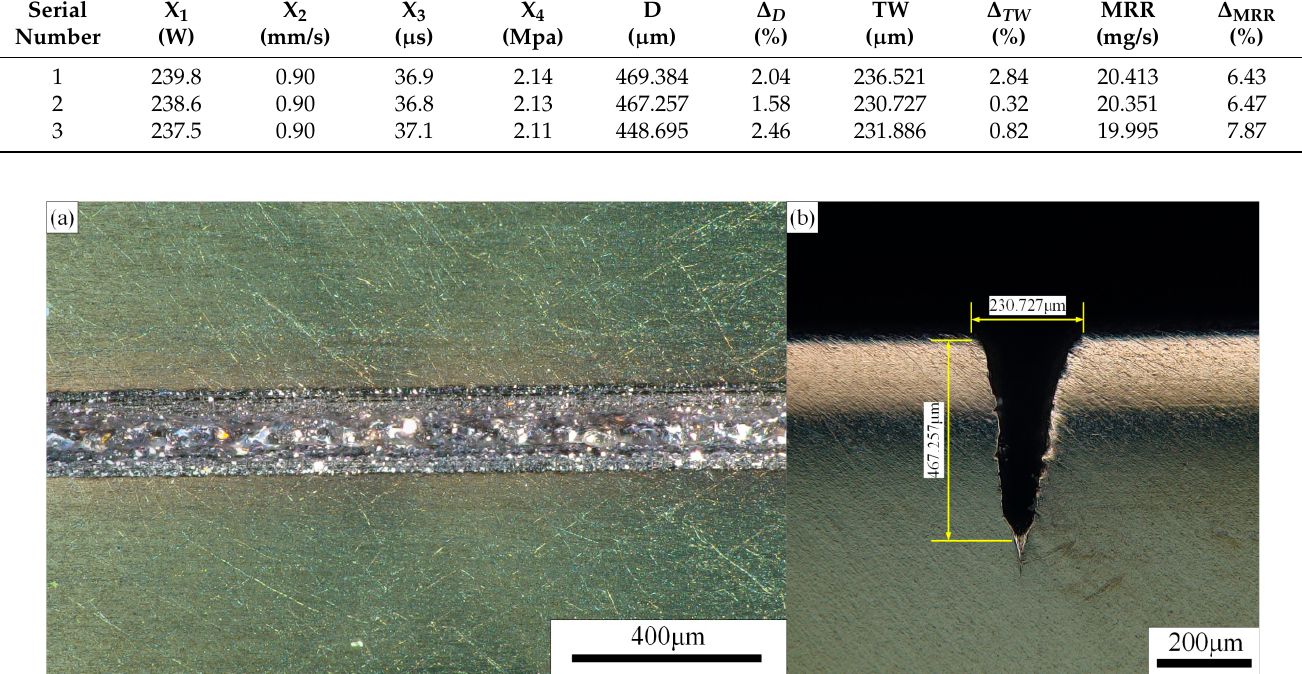
Figure 18. Microgroove morphology after optimization of process parameters. ( a ) Surface morphol- ogy, ( b ) Cross-sectional morphology. Table 12. Validation test results of optimization scheme.